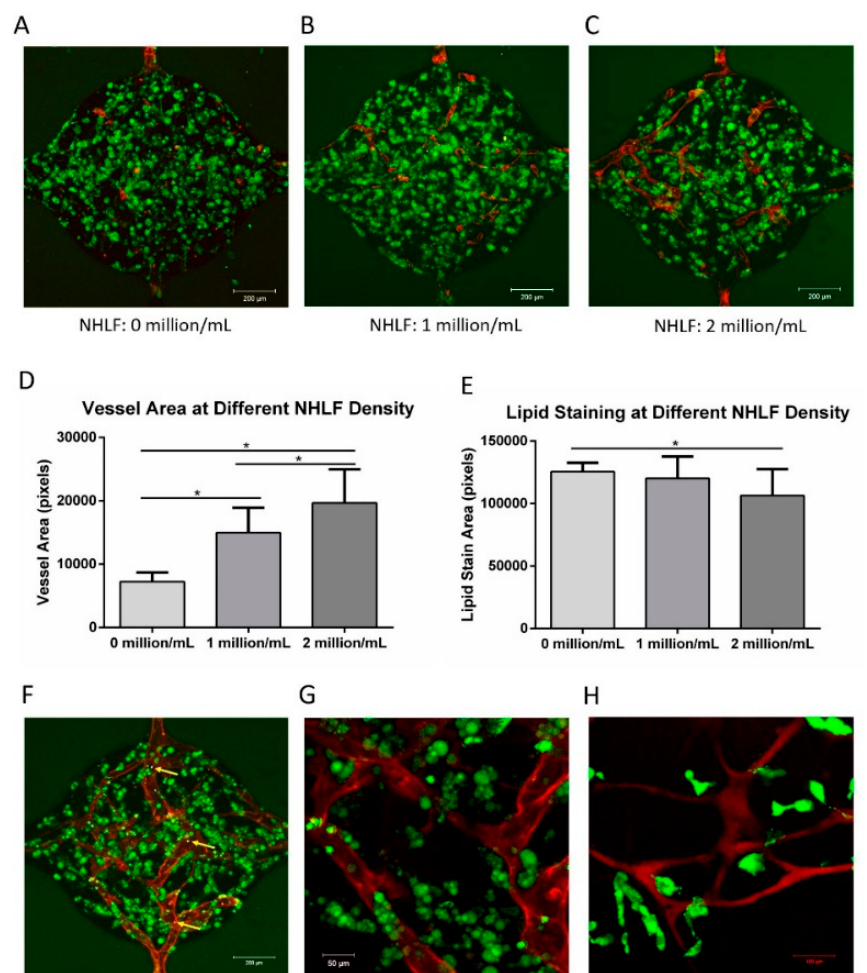
Figure 10. Formation of vascularized adipose tissue. ( A ) Vessel formation and lipid accumulation without NHLF. ( B ) Vessel formation and lipid accumulation with 1 million/mL NHLFs. ( C ) Vessel formation and lipid accumulation with 2 million/mL NHLFs. ( D ) Quantification of vessel formation at different NHLF densities, indicating that vessel formation increases with NHLF. ( E ) Quantification of lipid accumulation at different NHLF densities. ( F ) Microspheres present within the vessel structures (yellow arrows). ( G ) Higher magnification image of (F) stained with CD 31 (red) and lipid droplets (green). ( H ) Dextran perfusion (red) was used to show the functional vessel structures, and perfused fatty acid (green) is taken up by cells in the tissue interstitium. For all the datasets, the values are mean ± SD, n = 12–16. One-way ANOVA followed by Tukey’s multiple comparisons test was performed. *Denotes significant difference ( p < 0.05) between the marked groups.